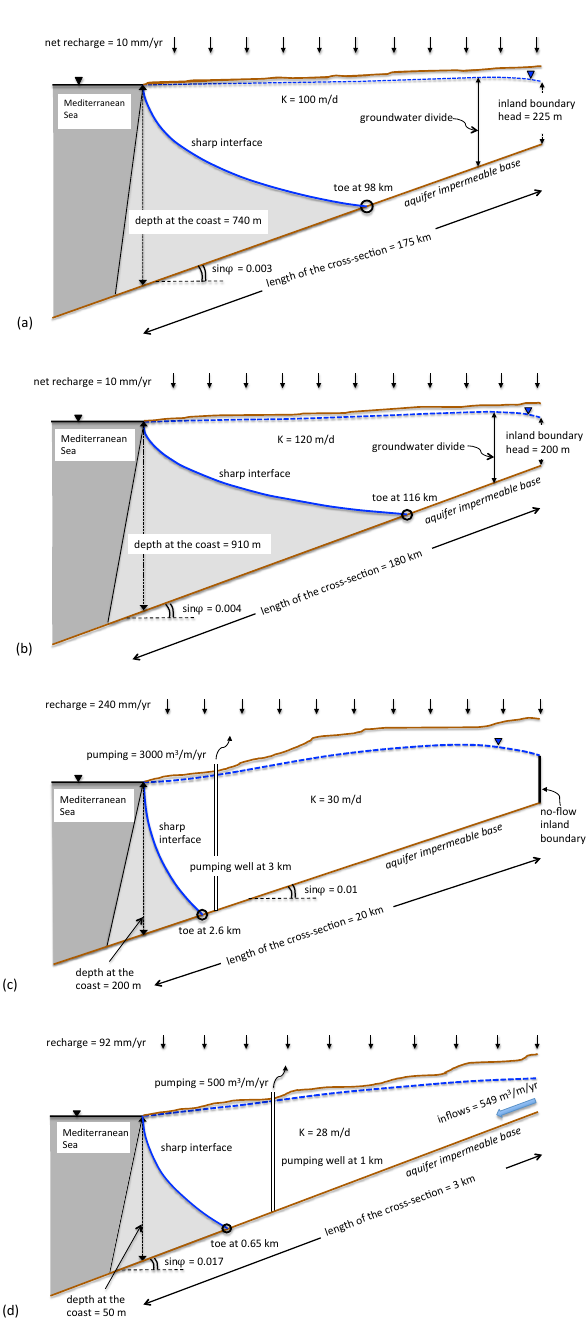
Fig. 3. Schematized modeled cross sections: (a) middle Nile Delta aquifer, (b) east Nile Delta aquifer, (adapted respectively from Fig. 17.2 and 17.3 in Sherif, 1999), (c) Israel Coastal aquifer and (d) Cyprus Akrotiri aquifer. The model calculations assume for all aquifers a vertical cliff coastal